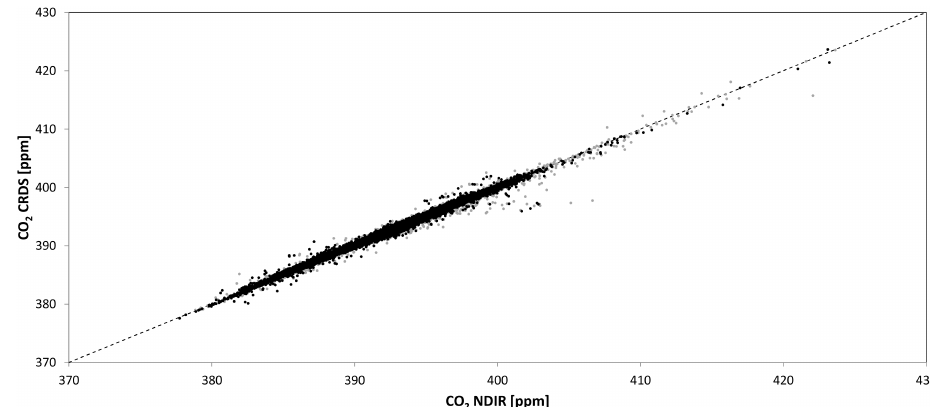
Figure 2. The hourly averages of the CRDS CO 2 measurements versus the hourly averages of the NDIR CO 2 measurements (grey points) and the CRDS CO 2 measurements versus the hourly averages of the NDIR CO 2 measurements without periods of rapid mole fraction changes (black points) over the whole period of comparison. The dashed diagonal represents the ideal 1 : 1 agreement. Considering all data points, the R 2 is 0.9909 with a slope of 0.9908ppmppm − 1 and an intercept of 3.6623ppm. Excluding periods with rapid mole fraction changes, the agreement of the two data sets is slightly better with a R 2 of 0.9924, a slope of 0.9961ppmppm − 1 and an intercept 1.5696ppm.